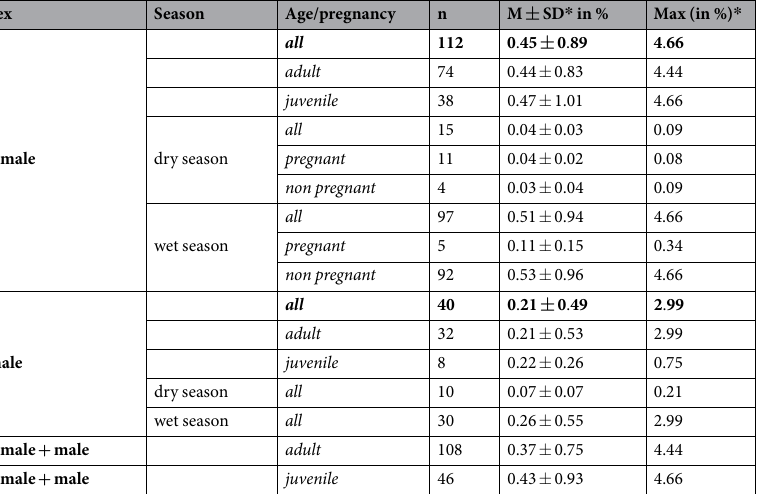
Table 3. Parasitemia values in different sex and age groups. Table 3 lists parasitaemia values of Hepatocystis infections sorted in different sex and age host groups. Given are mean parasitaemia (M) and Standard Deviation (SD) as well as maximum parasitaemia (Max) in %, * minimum parasitaemia for all groups < 0.001%. Within each sex, there were no significant differences in parasitaemia levels between adults and juveniles (females: t = 0.216, df = 110, p = 0.829; males: t = 0.018, df = 38, p = 0.985). Overall, females had significantly